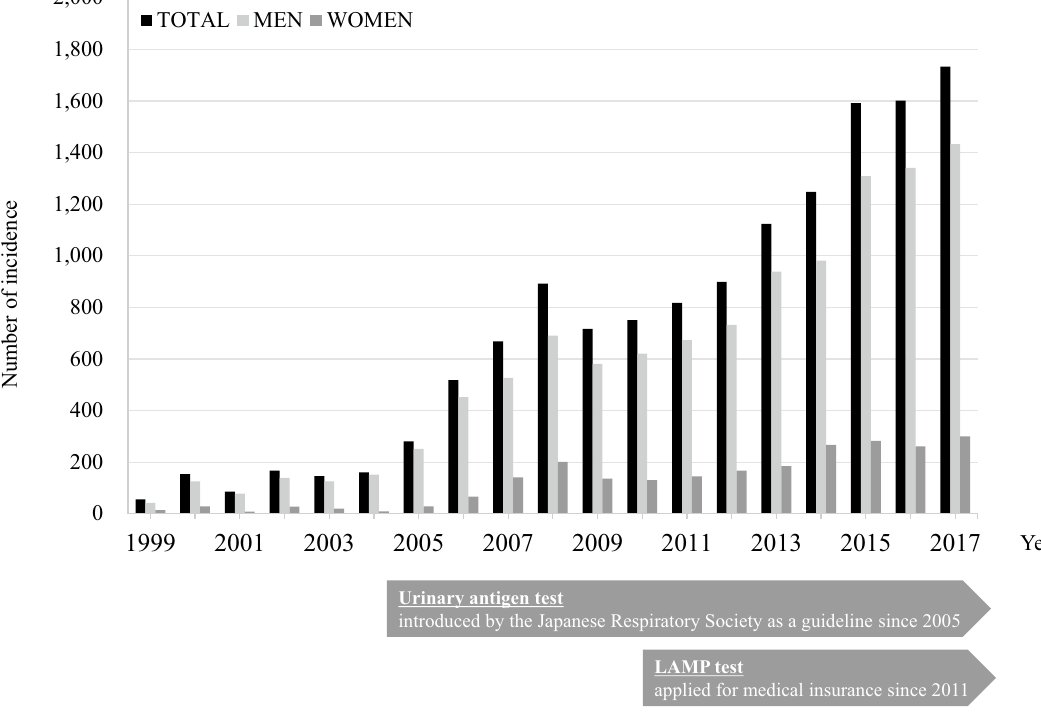
Figure 1. Chronological changes in the number of reported cases of legionellosis in Japan, 1999–2017. The urinary antigen test was introduced in a clinical guideline by the Japanese Respiratory Society in 2005. Then, LAMP (Loop-mediated Isothermal Amplification) method for the diagnosis of legionellosis was approved by the medical insurance in